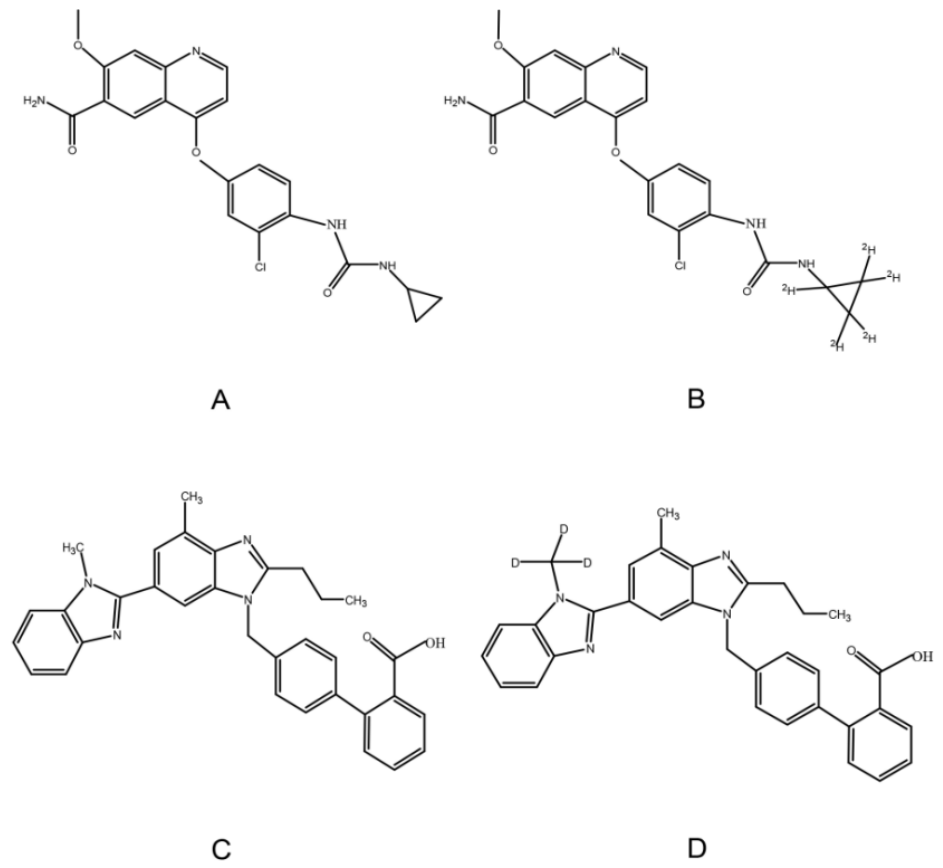
Figure 1. Chemical structure of LEN ( A ), 2 H 5 -LEN ( B ), TEL ( C ), and TEL-d 3 ( D ). Telmisartan (TEL), a highly selective ARB, can be used in the treatment of hypertension (Figure 1). Compared with other ARBs, TEL has higher lipophilicity and can cross the membrane more easily [18,19]. Moreover, TEL has a long half-life (24 h) that can sustain and significantly lower blood pressure, and it can also reduce cardiovascular risk